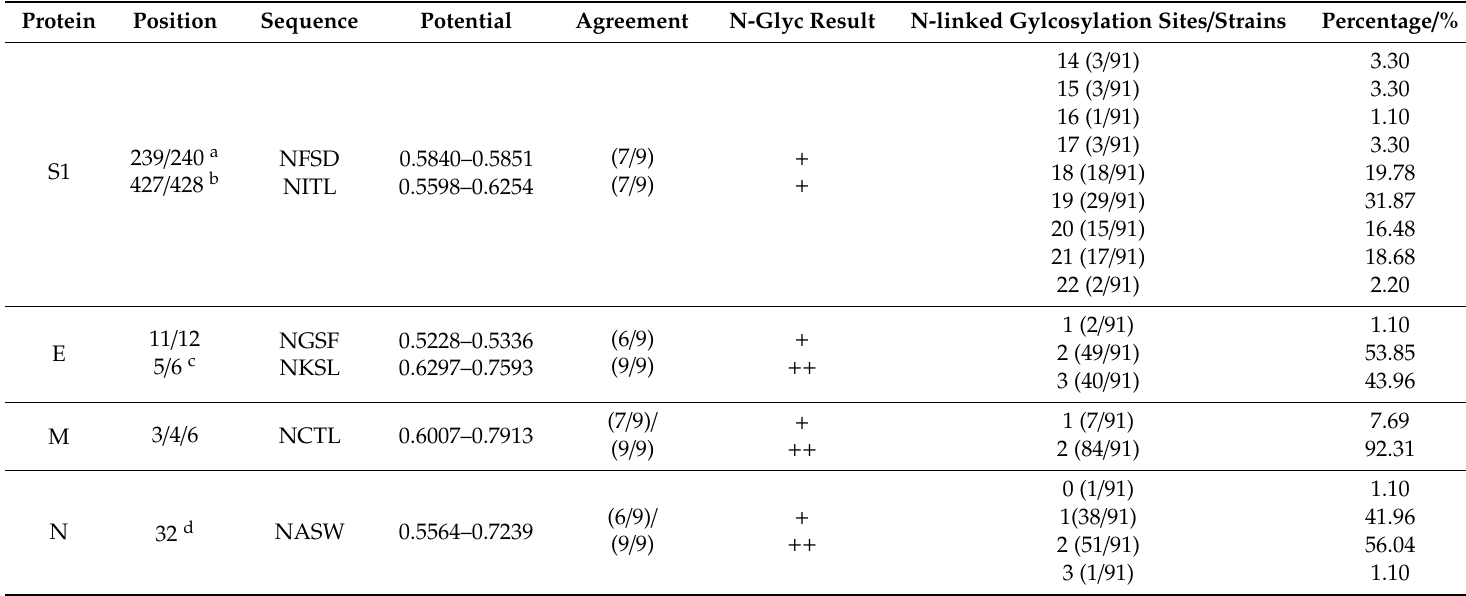
Table 4. Prediction results of IBVs by NetNGlyc 1.0